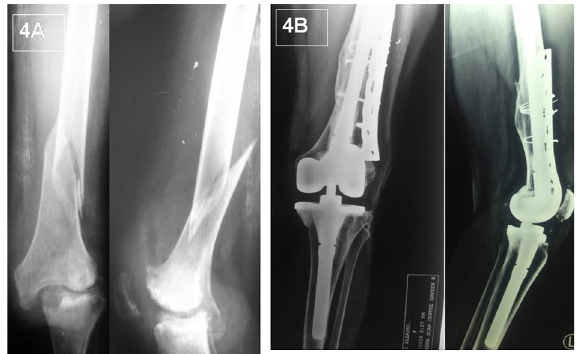
Figure 4. (A) Preoperative X-rays for a 63 rheumatoid lady with advanced knee arthritis and acute distal femoral